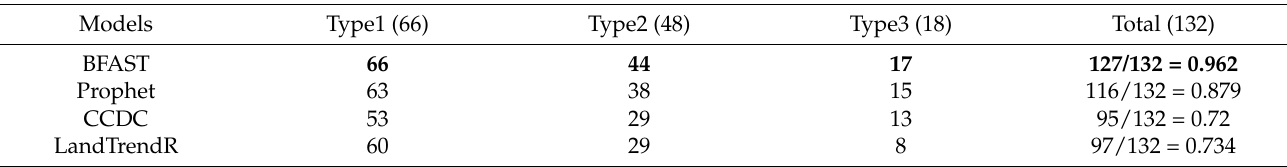
Table 1. Detection results for the four change detection models for different types of time